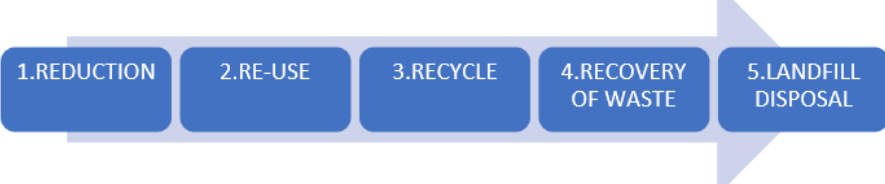
Figure 9. Options for waste management Source: Own elaboration.